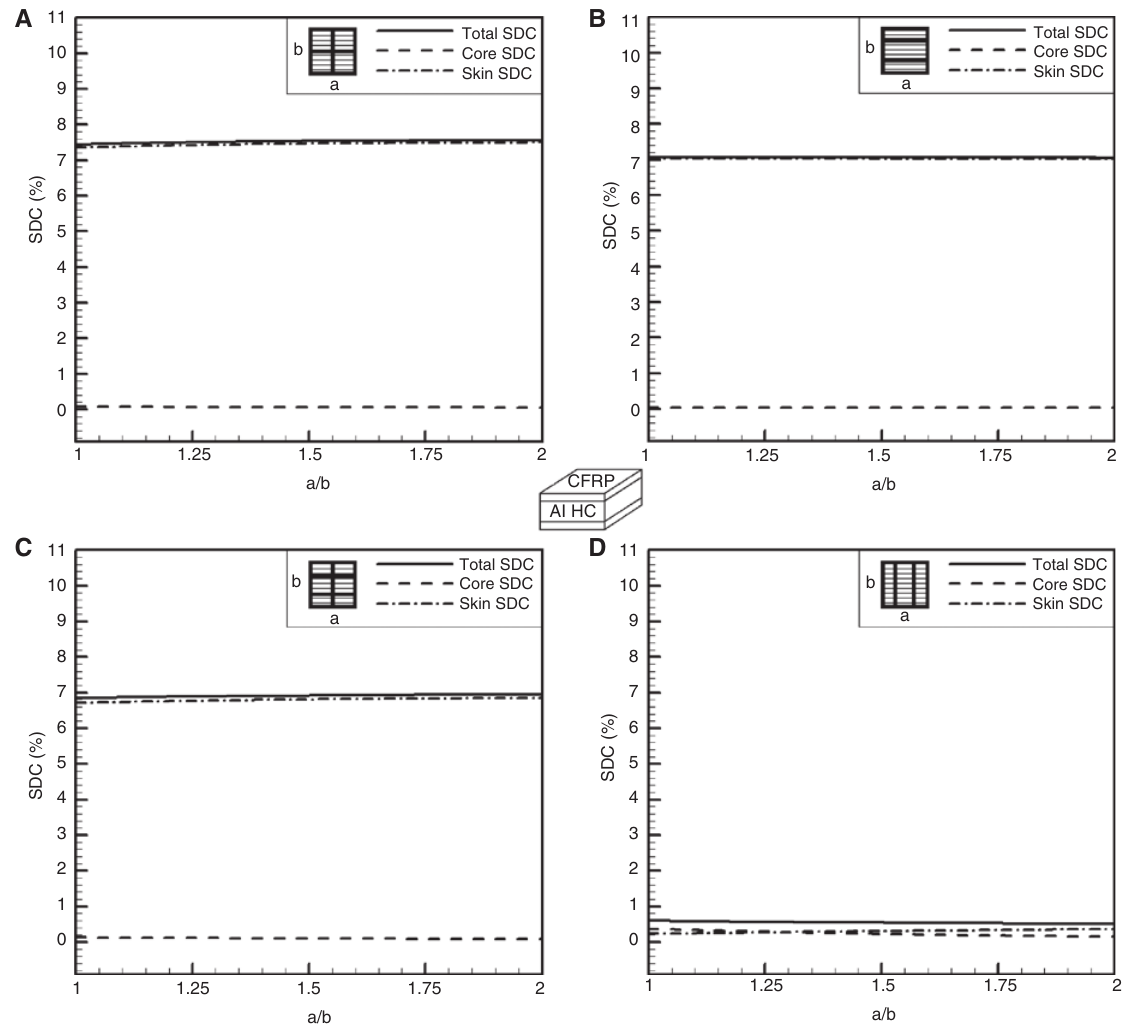
Figure 8: Damping of an all-free, all-zero CFRP/Al honeycomb sandwich panel versus aspect ratio, in various modes. (A) First mode, (B) second mode, (C) third mode, (D) fourth